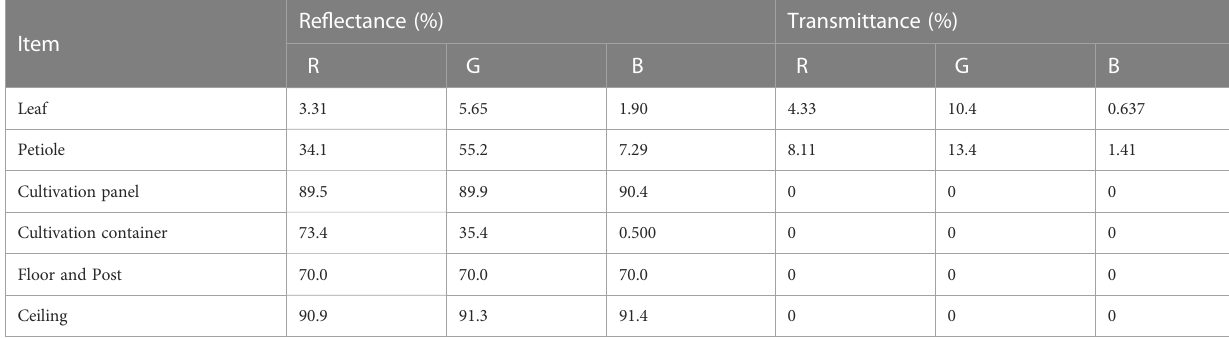
TABLE 1 The optical properties of items in the optical simulation.